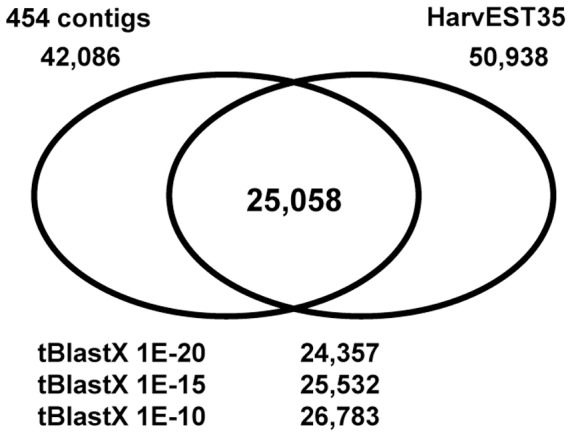
Comparison of 454 sequences with public barley sequence information.Venn diagram displays the number of overlapping sequences between ETC-454 contigs and sequences of the HarvEST assembly 35 (BlastN <1E-20). Commonalities using tBlastX searches with different stringencies are given at the bottom.